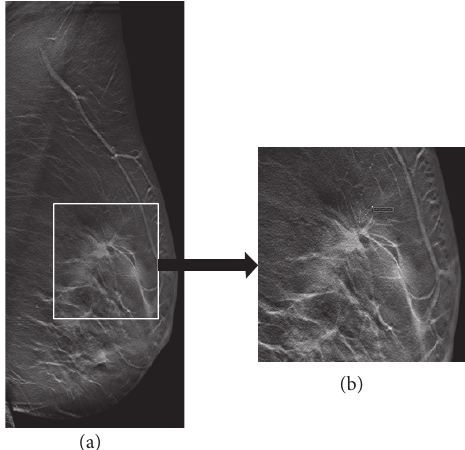
Figure 2: Left mediolateral oblique Tomosynthesis image section (a), with pathologic area close-up view (b). There was improved architectural distortion visualization further localized to the upper outer quadrant. Close-up view shows a small central mass with large spicules and focal retraction along the margin of the tissue: Rocha A, Servicio de Radiologia, Hospital Povisa, Vigo,